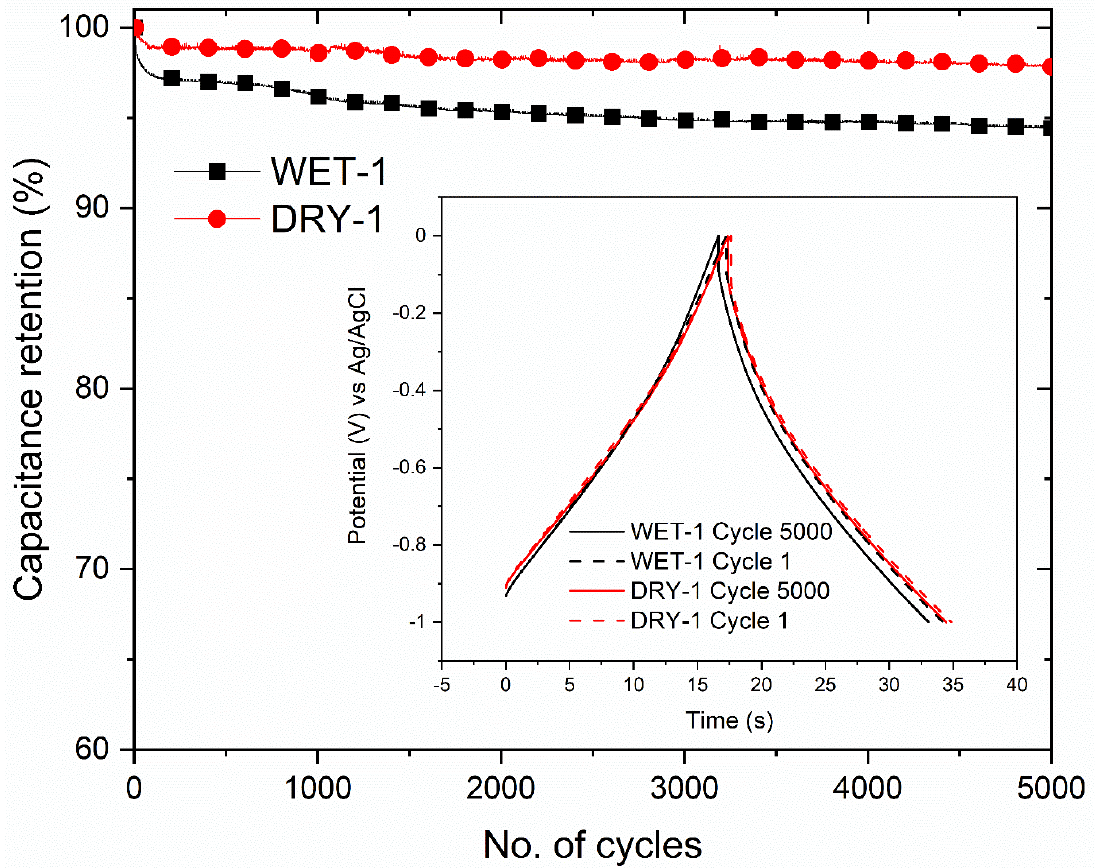
Figure 8. Cycling stability tests at a current density of 5 A/g with the insert showing the charge– discharge cycles at the start and end of test.